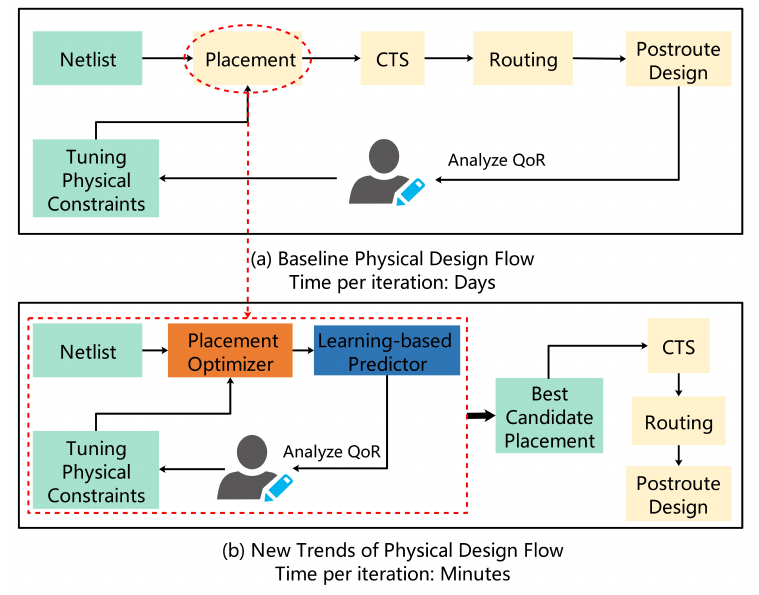
Figure 2. New trends of placement-centric VLSI physical design flow. This flow contains two key technologies: (i) a placement optimizer, which contains algorithm improvement and computational acceleration, and (ii) a learning-based predictor, which is used to classify postplacement results.